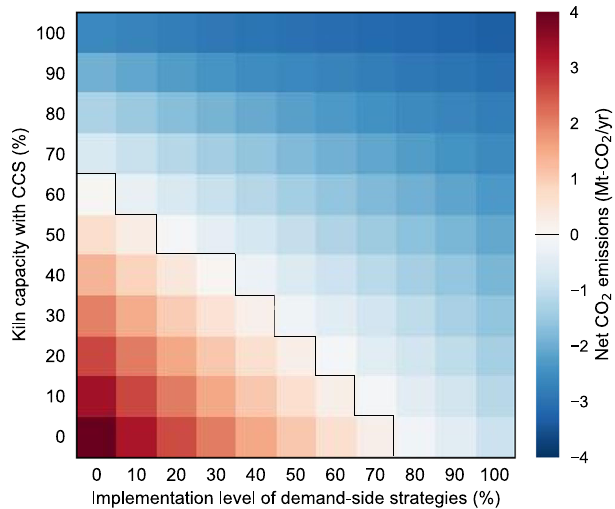
Fig. 6 Sensitivity of 2050 net CO 2 emissions attributable to the cement and concrete cycle in Japan to the implementation level of demand-side strategies and the proportion of kilns equipped with carbon capture and storage (CCS). The black lines mark the divisions between pathways that do (blue) and do not (red) achieve net-zero emissions. In all scenarios, all supply-side strategies are expected to be implemented except CCS, which is shown on the vertical